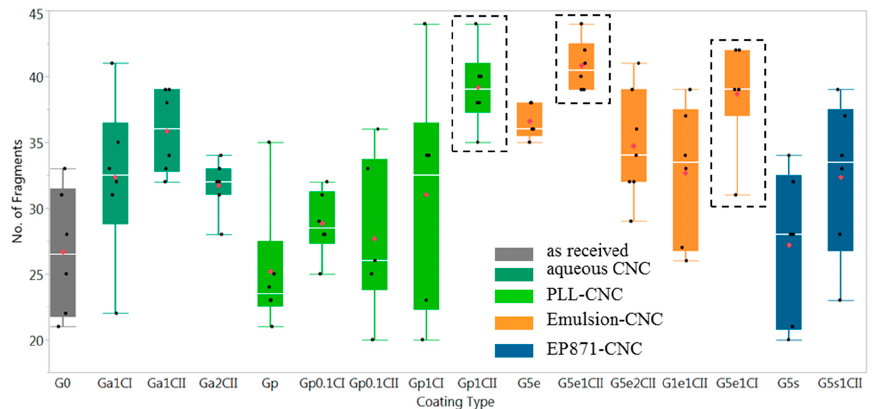
Figure 5. Comparison of the number of fragments observed from the SFFT for the different coating formulations on the GF. Box plot colors indicate different coating media. Grey (G: as received GF), green (a: aqueous only), bright green (p: aqueous with PLL), orange (e: emulsion), and blue (s: commercial emulsion). Box plots enclosed by dotted rectangles are coating formulations with a statistically significant difference in the mean number of fragments compared to G0.